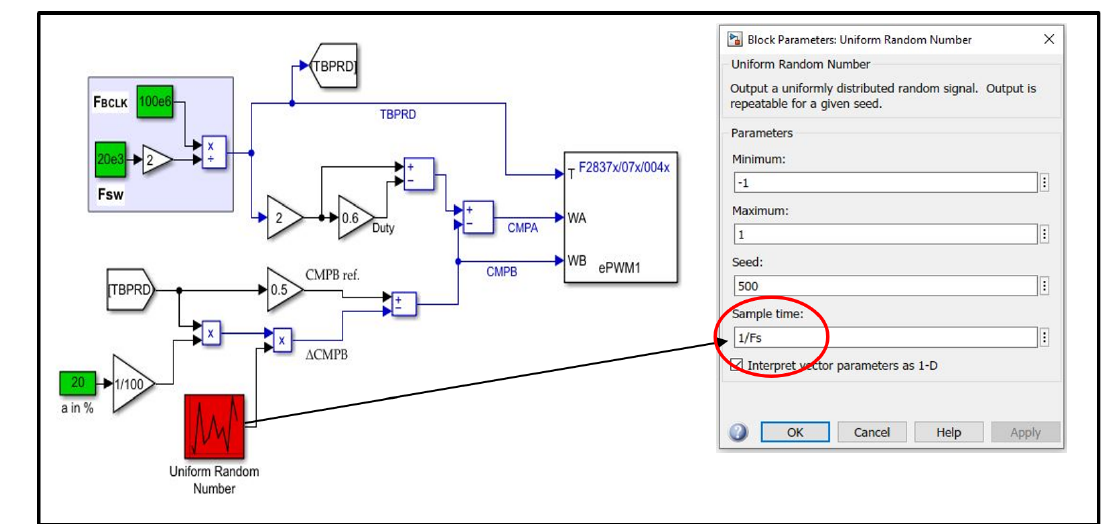
Figure A1. SIMULINK schematics of the implemented RPPM.